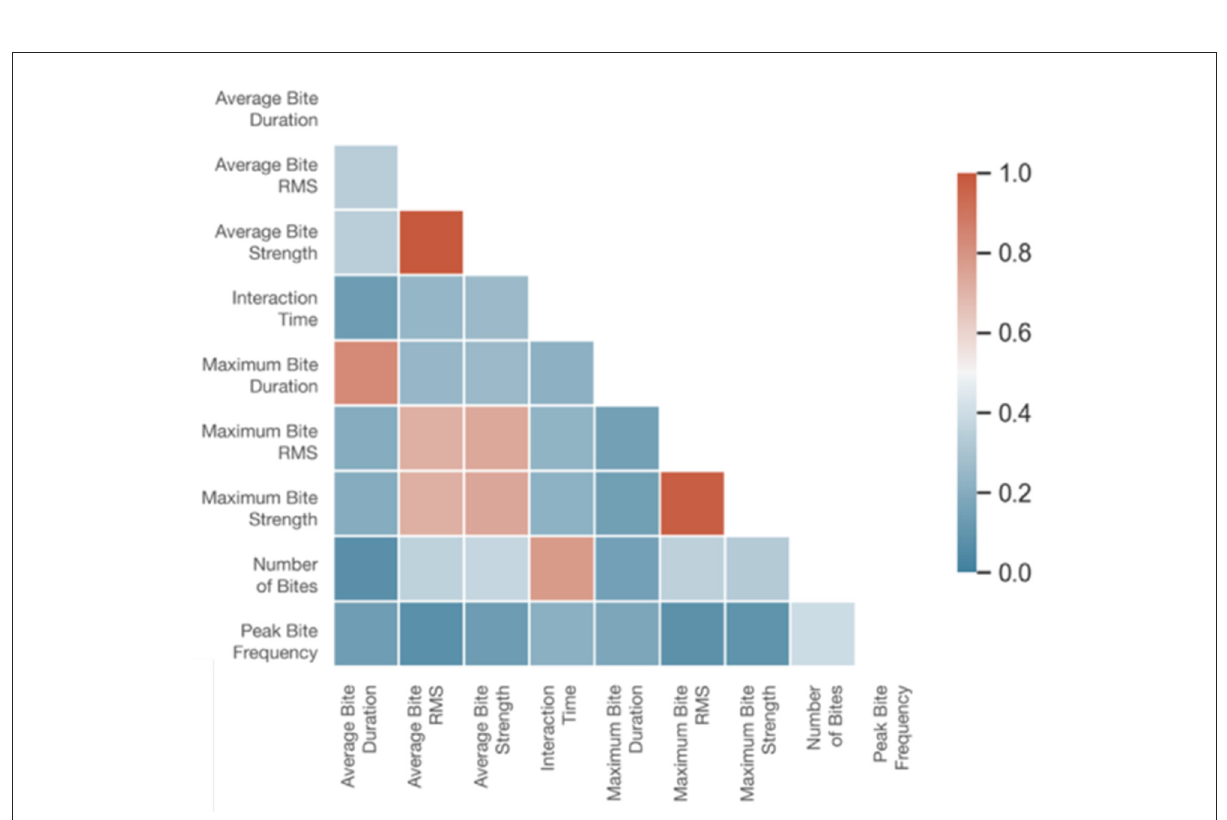
FIGURE5 Correlation matrix of CCI features collected by the instrumented ball (modeling feature importance with respect to class).